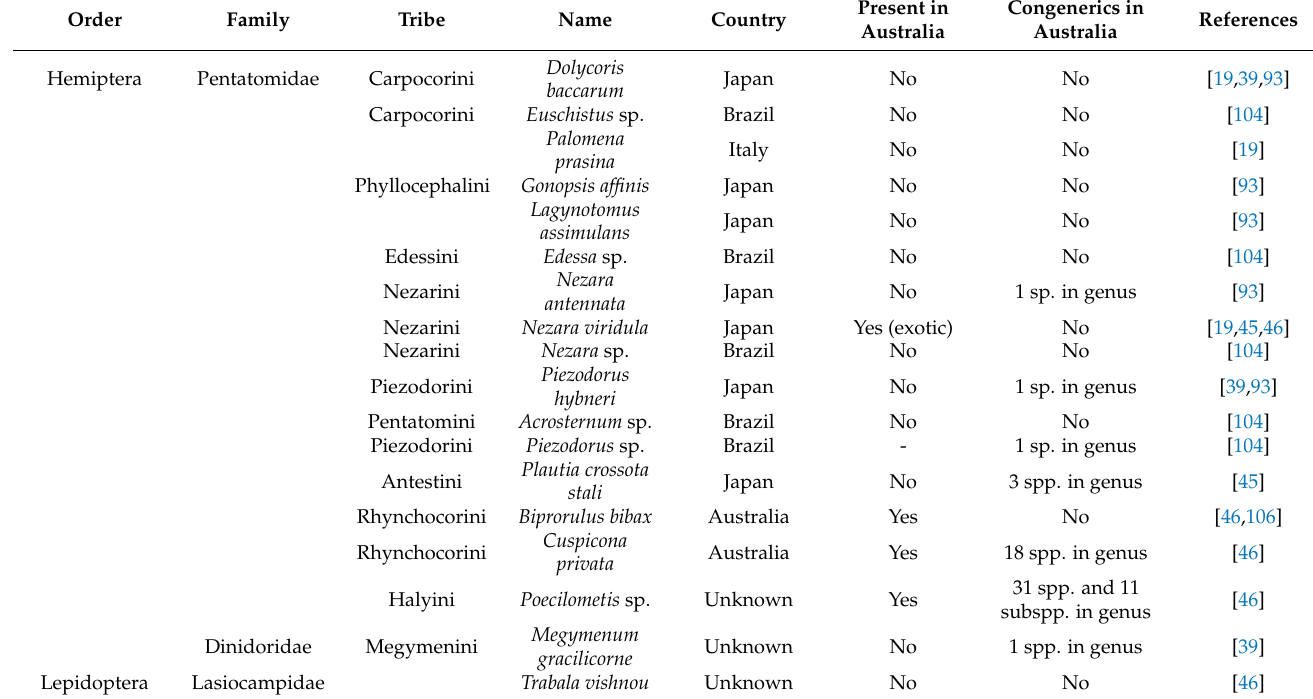
Table 2. Host range of Trissolcus mitsukurii including taxonomy of the host, country of occurrence, if present in Australia. Order Family